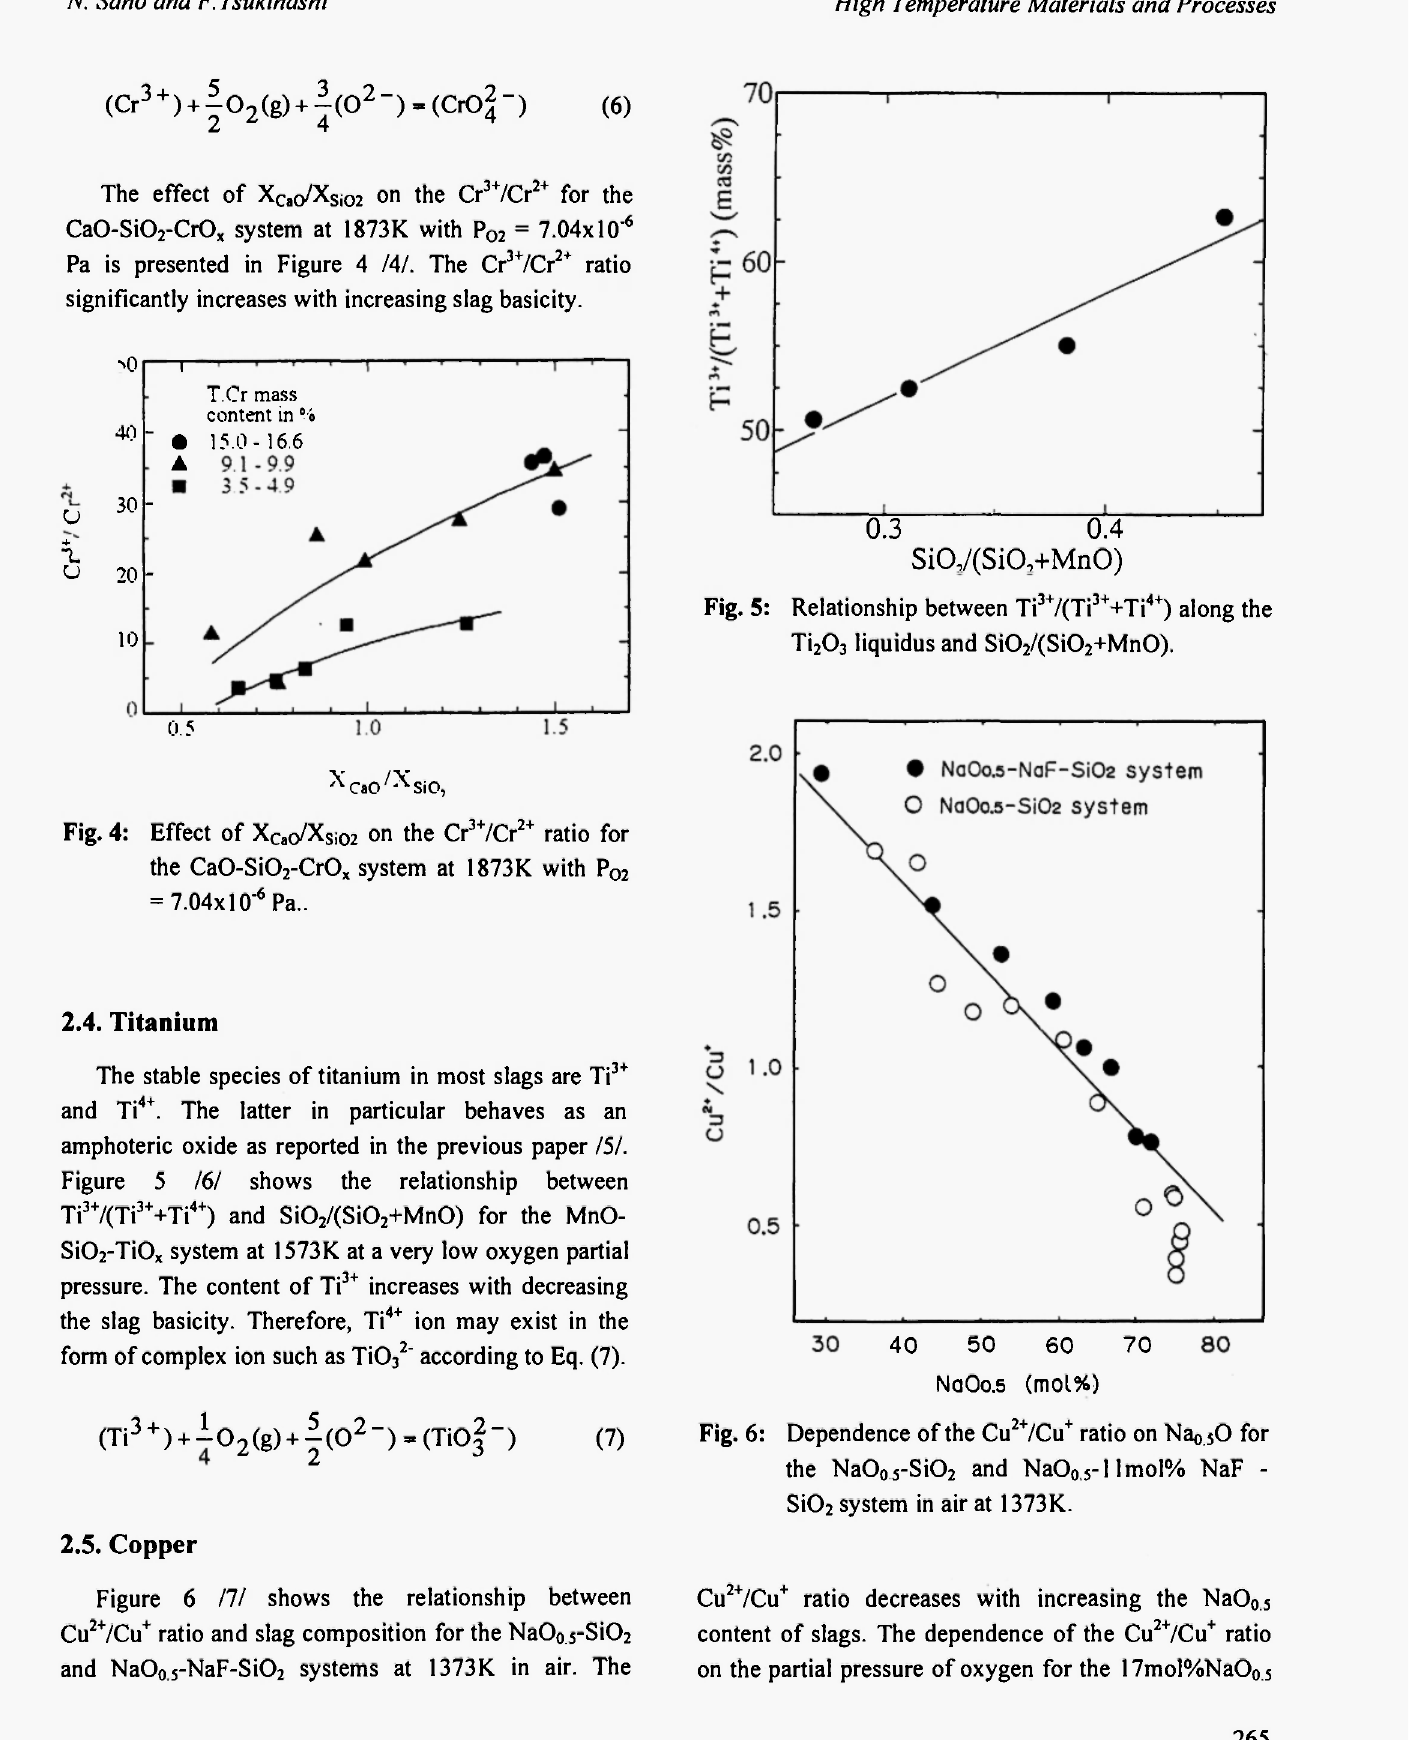
Cu 2+ /Cu + ratio decreases with increasing the NaO 0 .5 content of slags. The dependence of the Cu 2+ /Cu + ratio on the partial pressure of oxygen for the 17mol%NaO 0